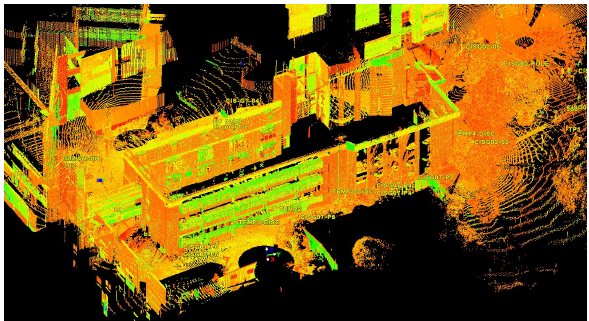
Figure 2: 3D point cloud acquired from a TLS system – here the outside of the building (colour indicates different intensity values).